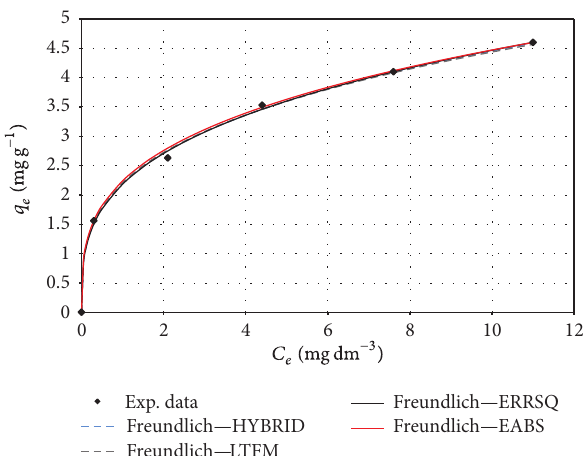
F 2: Experimental equilibrium data and Freundlich isotherms of p -NP biosorption on R. oryzae dead biomass